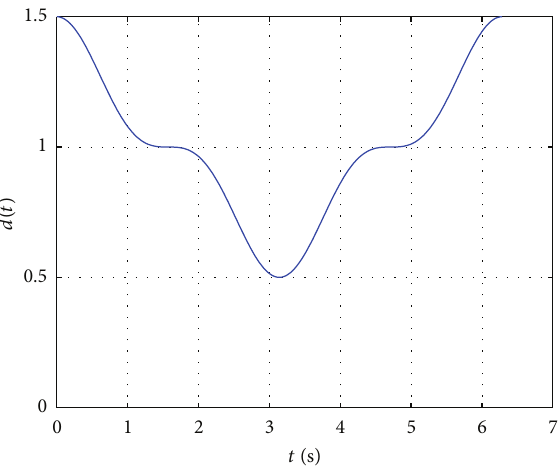
Figure 4: Interval time-varying delay 𝑑(𝑡) of Example 2.